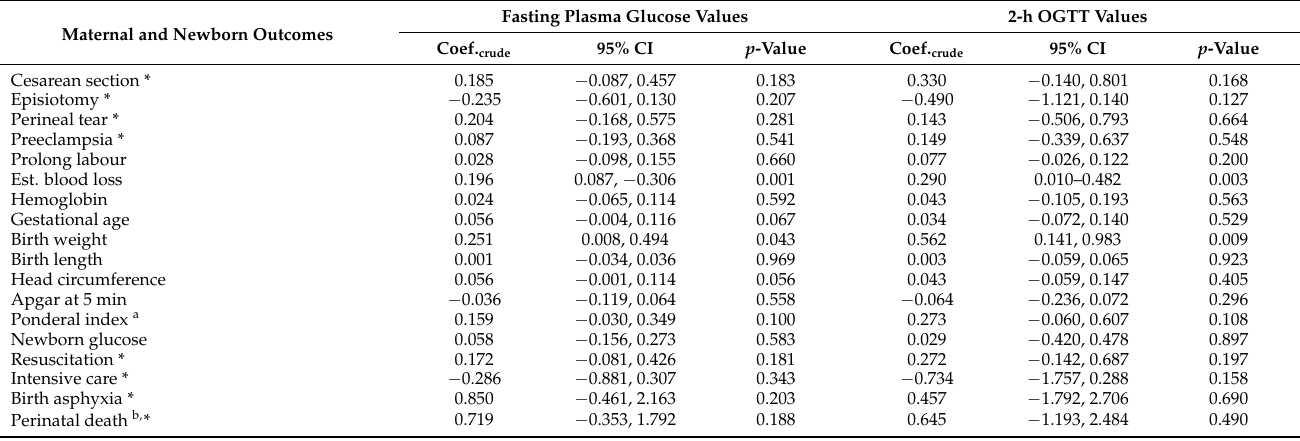
Table 4. Simple linear regression showing the coefficients of a unit rise in fasting plasma glucose and 2-h OGTT concentration on maternal and perinatal